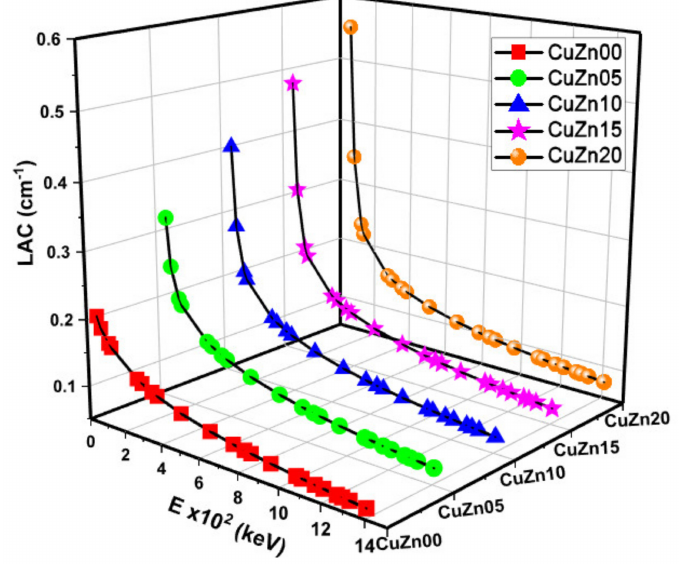
Figure 6. Linear attenuation coefficient (LAC) values as a function of photon energy and Cu-Zn content of samples.